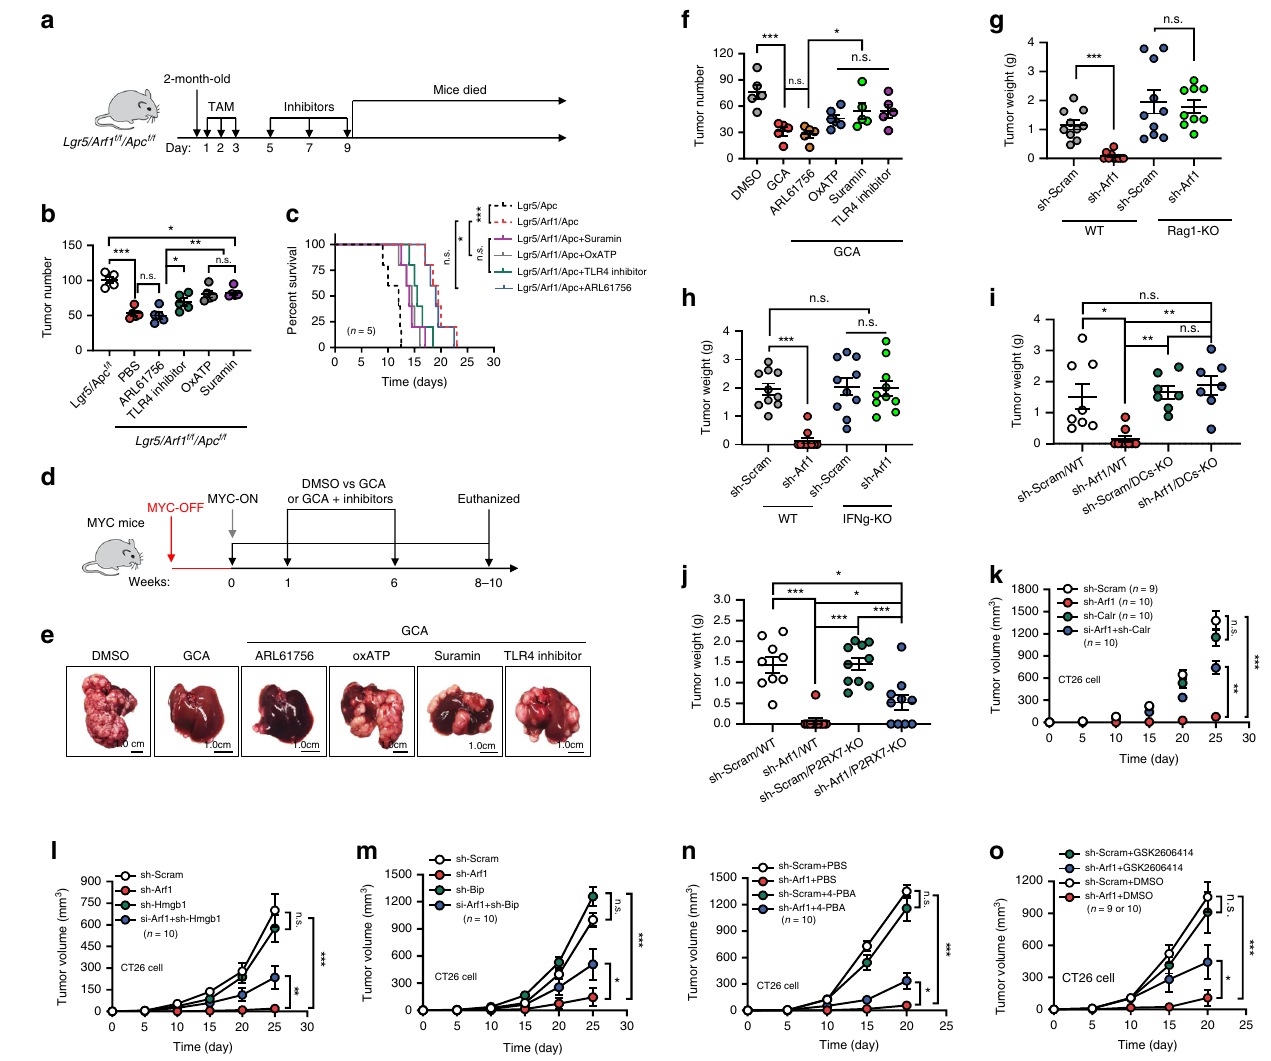
Fig. 6 Arf1 ablation induces anti-tumor immune responses through DAMPs. a Experimental setup for Lgr5/Arf1/Apc mice. TAM: injection of tamoxifen. b Tumor numbers in mice treated with the indicated inhibitors. c Survival curves of Lgr5/Arf1/Apc mice treated with the indicated reagents ( n = 5 mice each group; * p < 0.05, ** p < 0.01, *** p < 0.001, t -test; repeat two independent experiments). d Experimental setup for the MYC - ON liver tumor mice. e Representative liver images of MYC-ON mice treated with the indicated reagents. f Number of liver surface tumors in MYC-ON mice treated with the indicated inhibitors ( n = 5 mice per group; * p < 0.05, *** p < 0.001, t -test; repeat two independent experiments). g Tumor weight of wild-type or Rag1-KO C57BL/6J mice receiving B16-F10 cells treated with the indicated sh-RNAs (sh-Scram and sh-Arf1 in WT group, sh-Scram in Rag-KO group, n = 10 mice each group; sh-Arf1 in Rag-KO group, n = 9 mice; *** p < 0.001, t -test; polled two independent experiments). h Tumor weight of wild-type or IFN γ -KO BALB/c mice receiving CT26 cells treated with the indicated sh-RNAs ( n = 10 mice each group; * p < 0.05, t -test; repeat two independent experiments). i Tumor weight of wild-type or DCs-KO C57BL/6J mice receiving B16-F10 cells treated with the indicated sh-RNAs (sh-Scram/WT, n = 8 mice; sh-Arf1/ WT, n = 10 mice; sh-Scram/DCs-KO and sh-Arf1/DCs-KO, n = 7 mice; * p < 0.05, ** p < 0.01, *** p < 0.001, t -test; repeat two independent